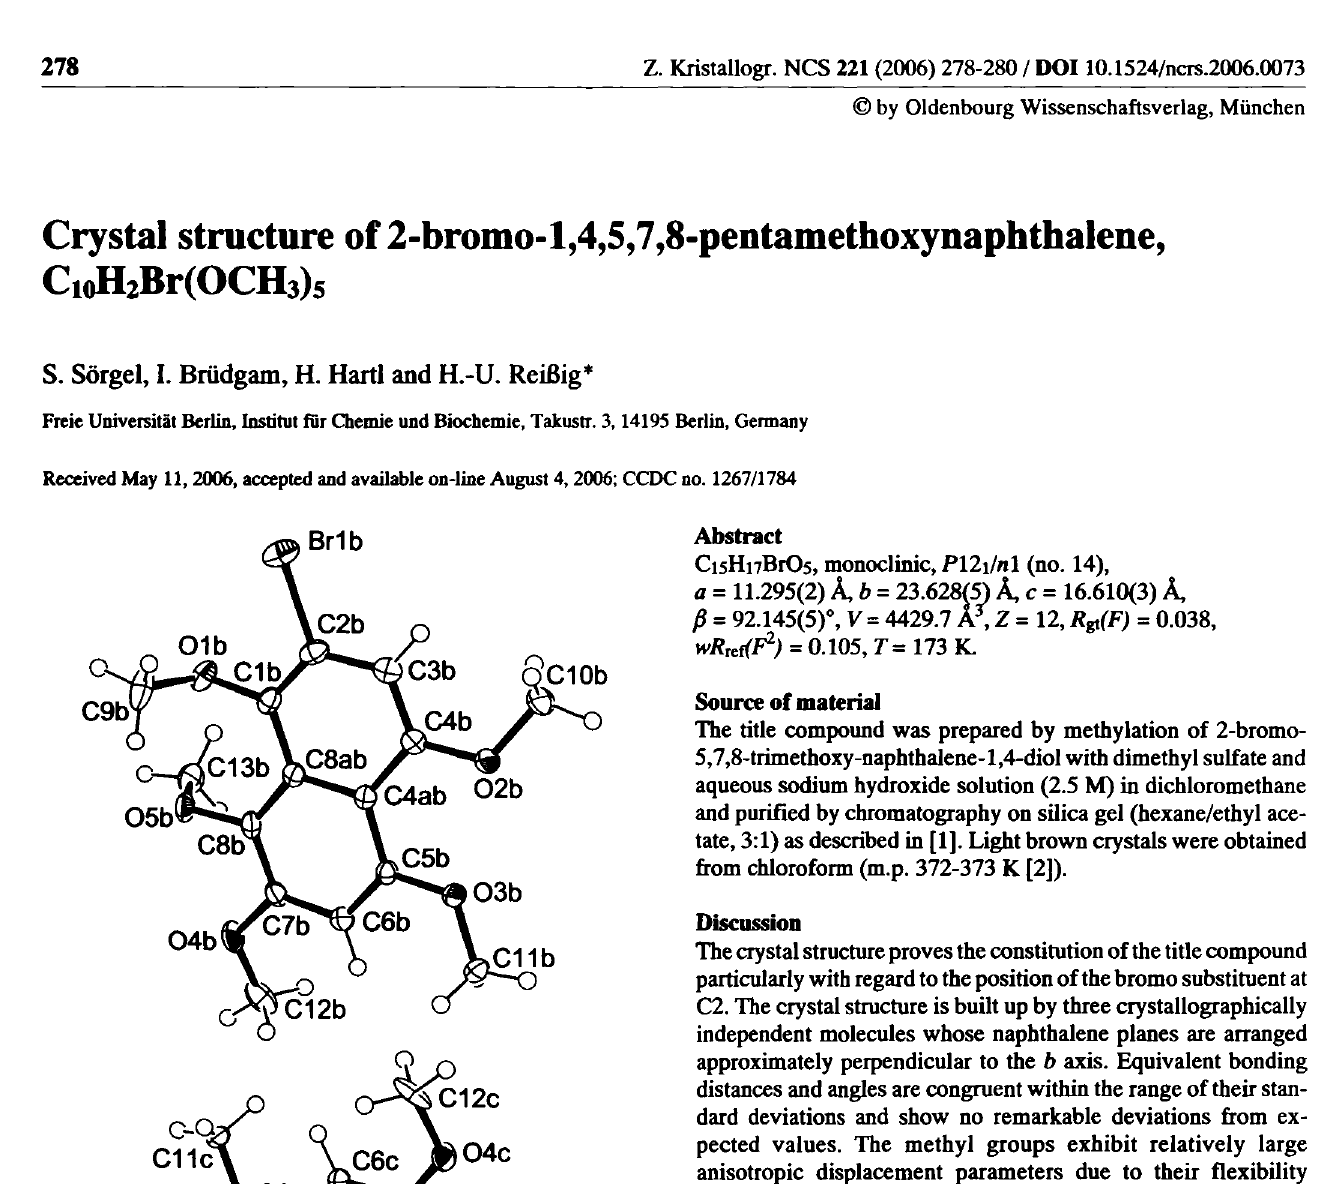
Table 1. Data collection and handling.